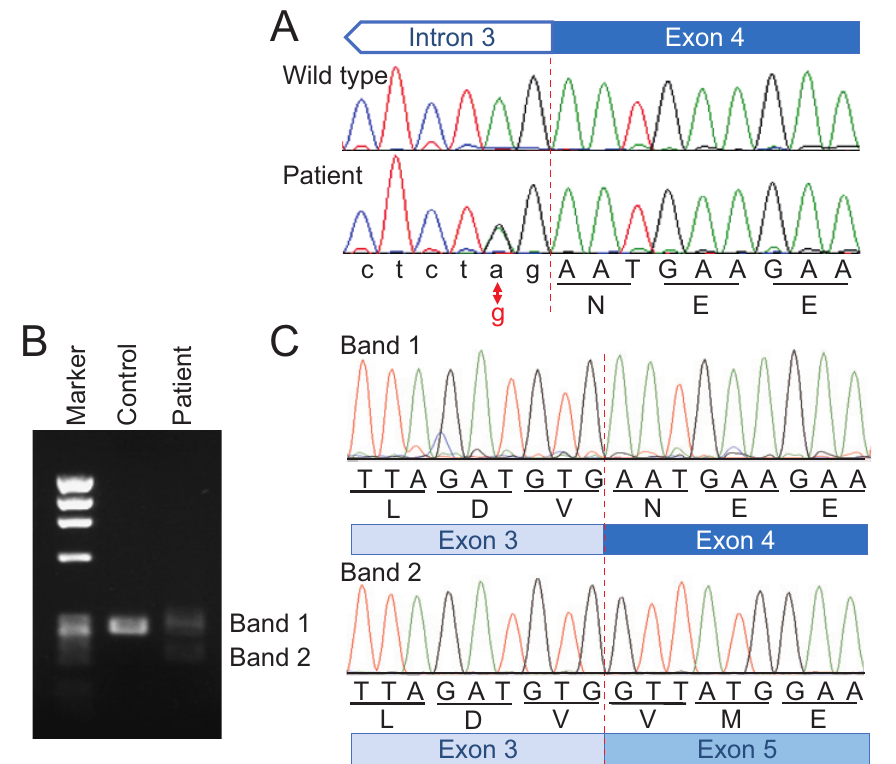
Fi g ure 3 Res u lts of molec u lar anal y ses. ( A ) Genomic seq u ence for the patient sho w s a n u cleotide alteration (a> g ) in the splicin g acceptor site of exon 4, w hereas control sho w s the w ild t y pe seq u ence. ( B ) Electrophoresis of the amplicons obtained after re v erse transcribed (RT)- P CR re v ealed an addi- tional short band (Band 2) in addition to the normal band (Band 1) in the patient. ( C ) San g er seq u ence for Band 2 confirmed exon 4 skippin g , w hereas Band 1 (expected to be deri v ed from the normal allele) sho w ed normal